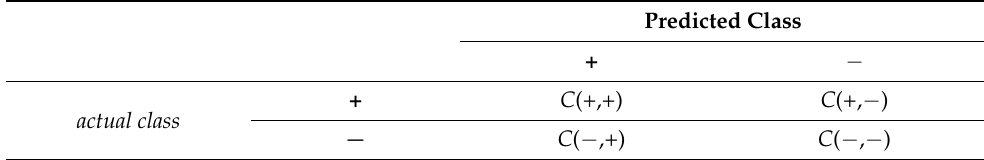
Table 1. Cost matrix for a binary classification problem.